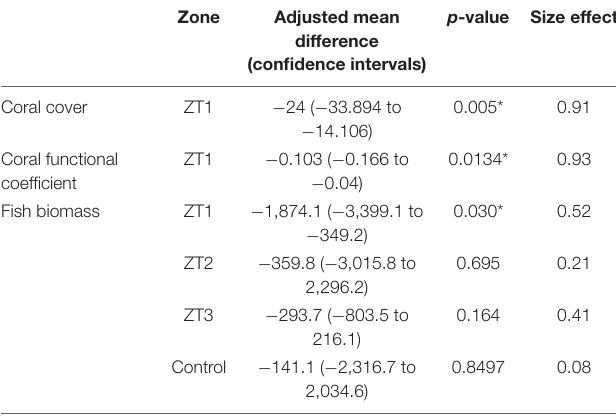
Frontiers in Marine Science |